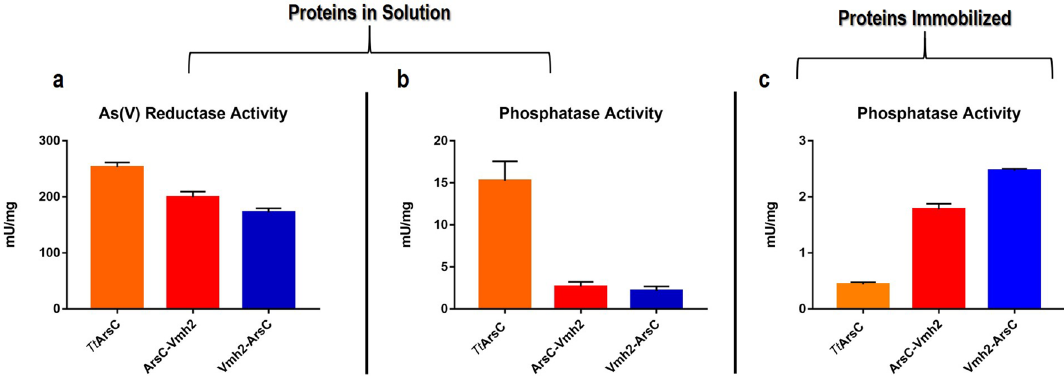
Figure 2. Graphical representation of the specific activities of Tt ArsC (yellow), Arsc-Vmh2 (red) and Vmh2- ArsC (blue). ( a ) As(V) reductase activity assay; ( b ) phosphatase activity assay; ( c ) phosphatase activity assay on the immobilized